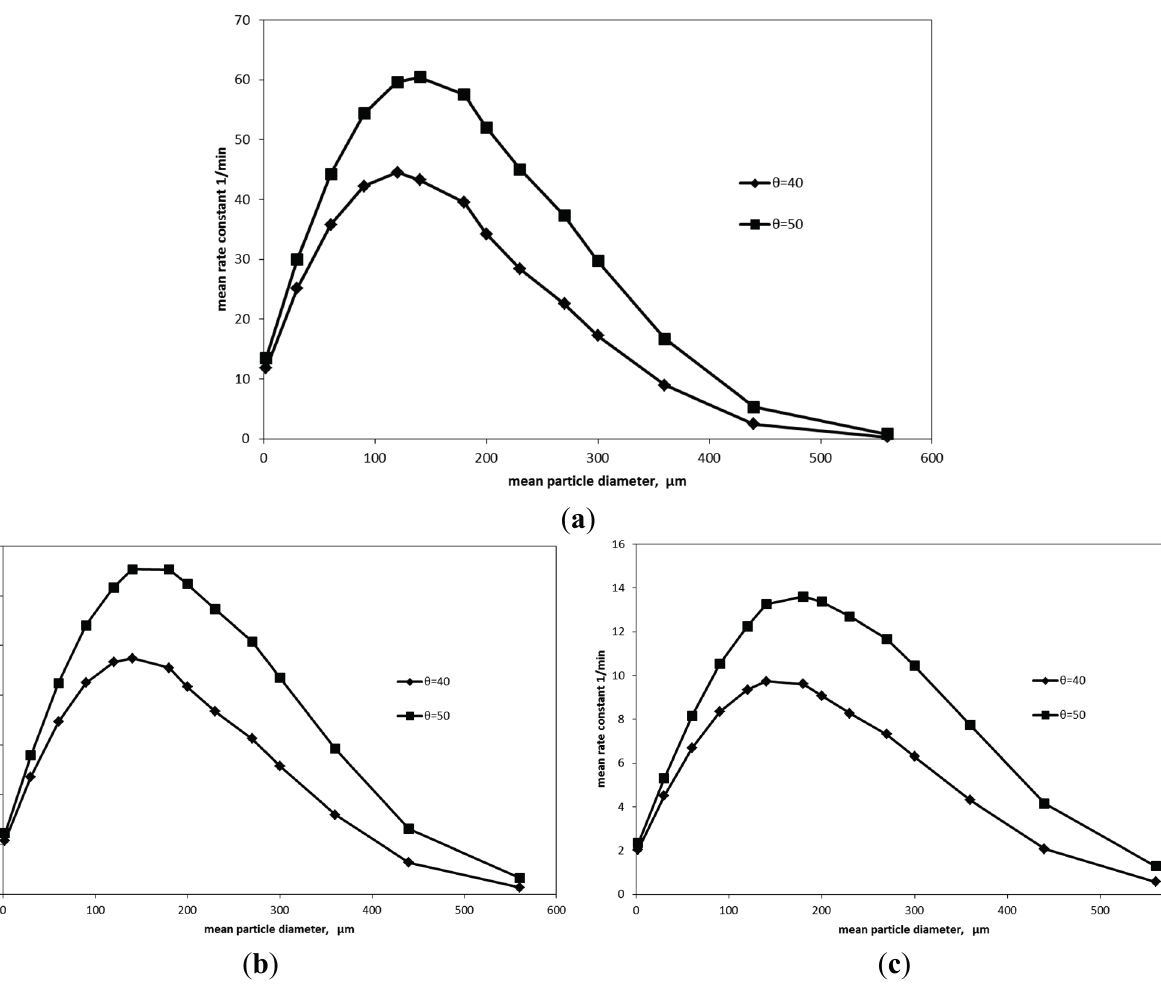
Figure 15. ( a ) Average rate constant for 0.5 mm bubble diameter and for particle no. γ -distribution; ( b ) average rate constant for 0.7 mm bubble diameter and for particle no. γ -distribution; ( c ) average rate constant for 1.0 mm bubble and diameter for particle no. γ